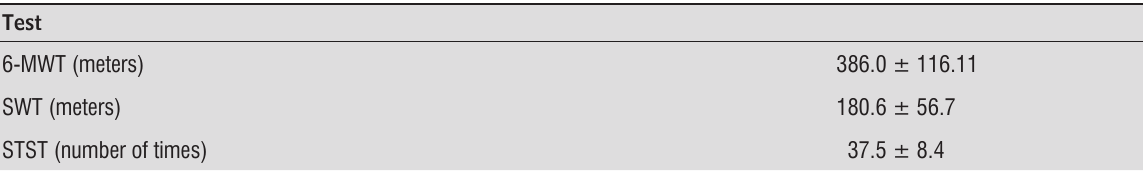
Table 2 - Functional capacity tests of the COPD group (n =